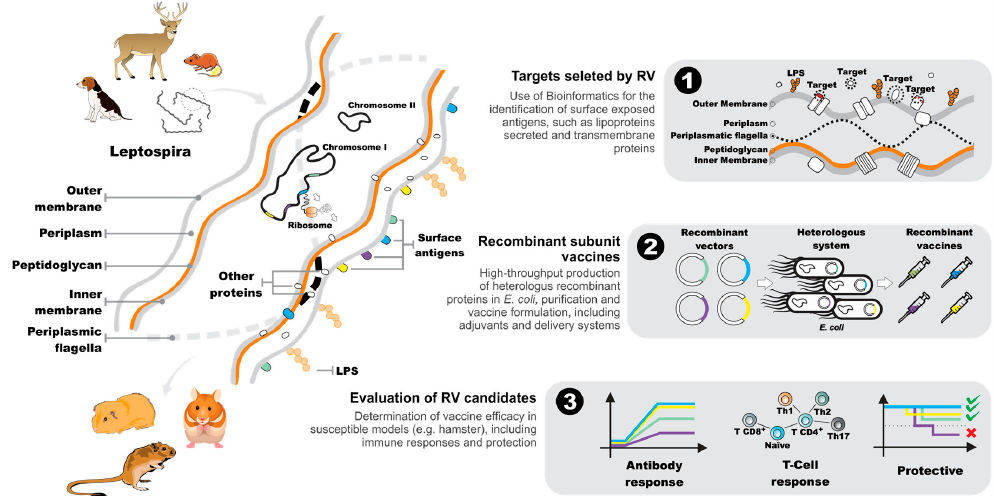
Figure 2. Schematic diagram of the reverse vaccinology process. The structure of the leptospiral cell and associated proteins is shown. Overview of the RV process: (1) selection of proteins from the genome sequence; (2) production of the recombinant subunit vaccines; and (3) evaluation of the RV candidates: protein-related humoral and cellular responses and protection against lethal challenge. LPS, lipopolysaccharide.